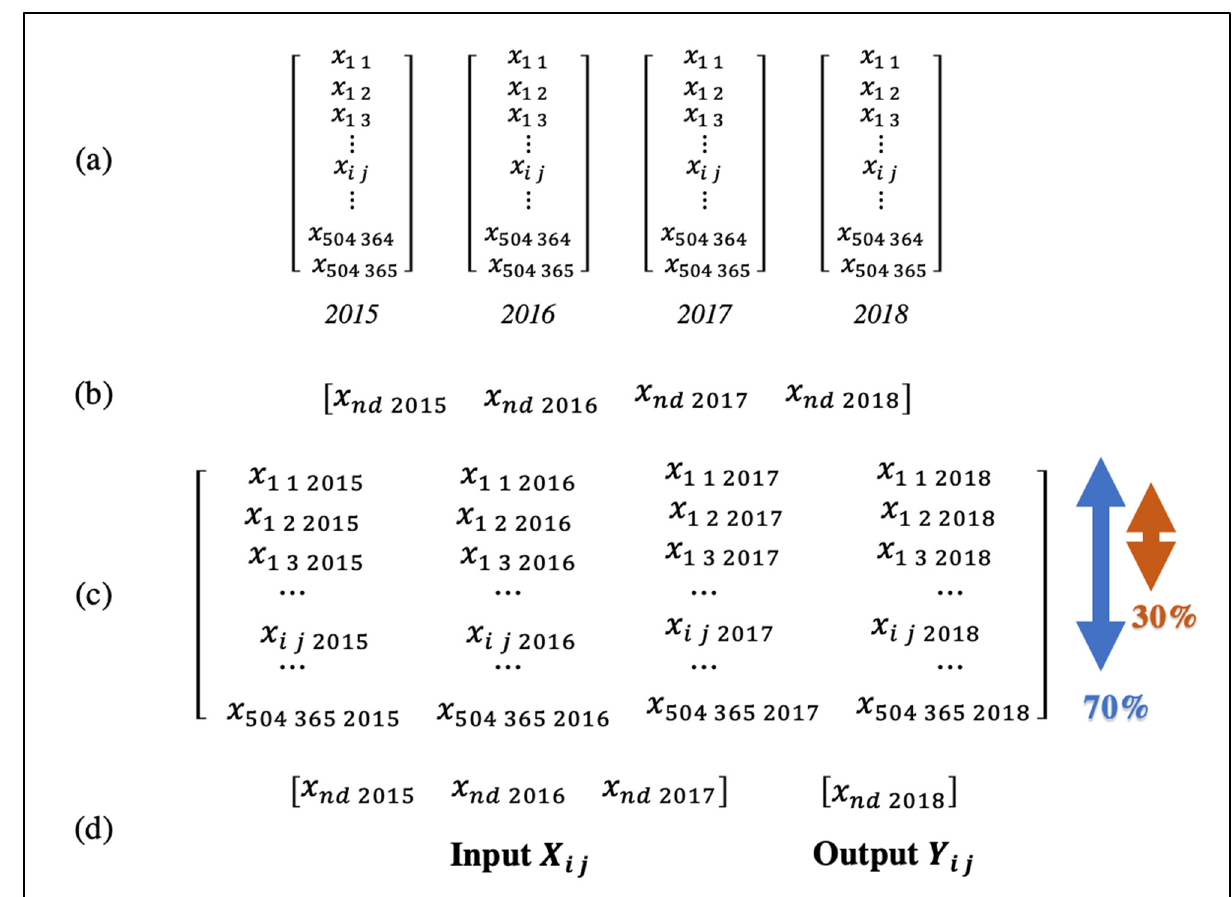
Figure 5. Visualization of solar irradiance values of a location sample of the years 2016–2018.